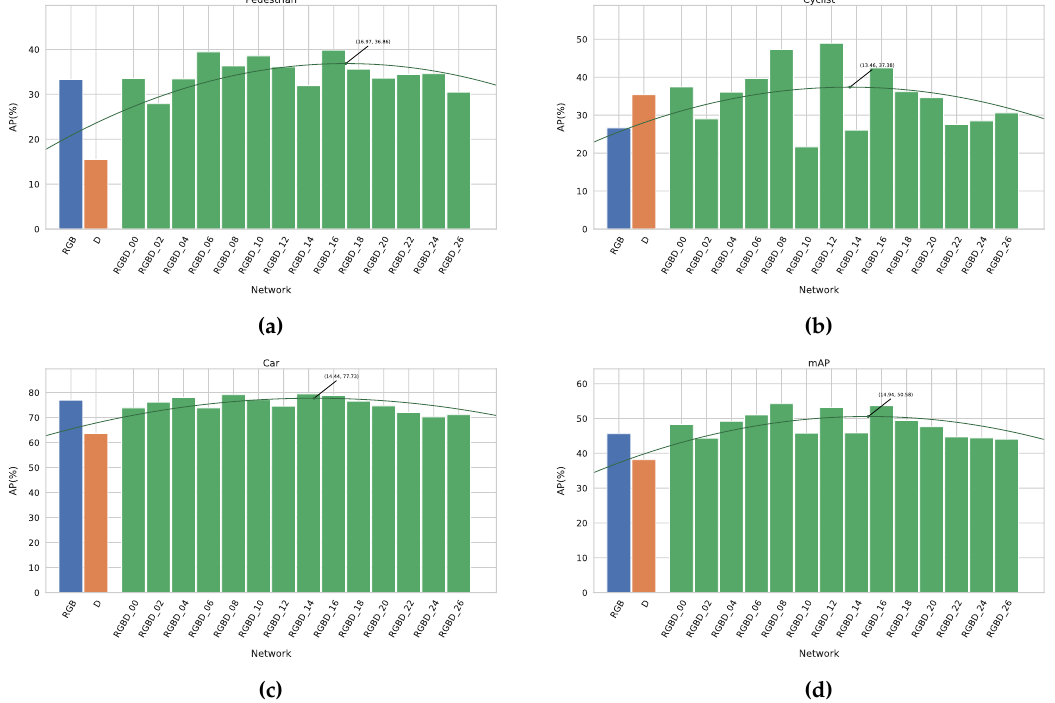
Figure 6. The regular AP metric of our different networks on the KITTI dataset (moderate difficulty). ( a ) Pedestrian class. ( b ) Cyclist class. ( c ) Car class. ( d )